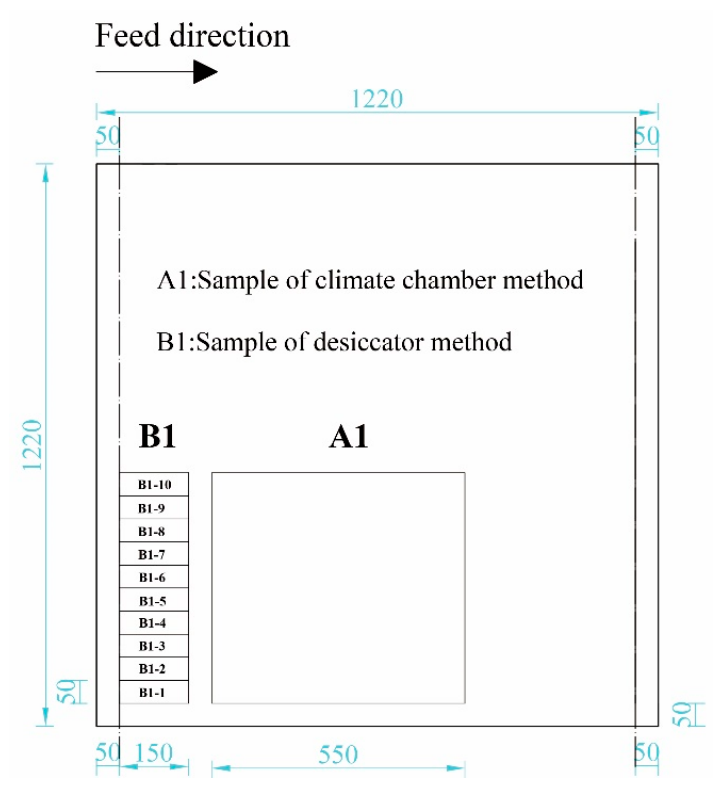
Figure 3. Sampling diagram of sample 2.